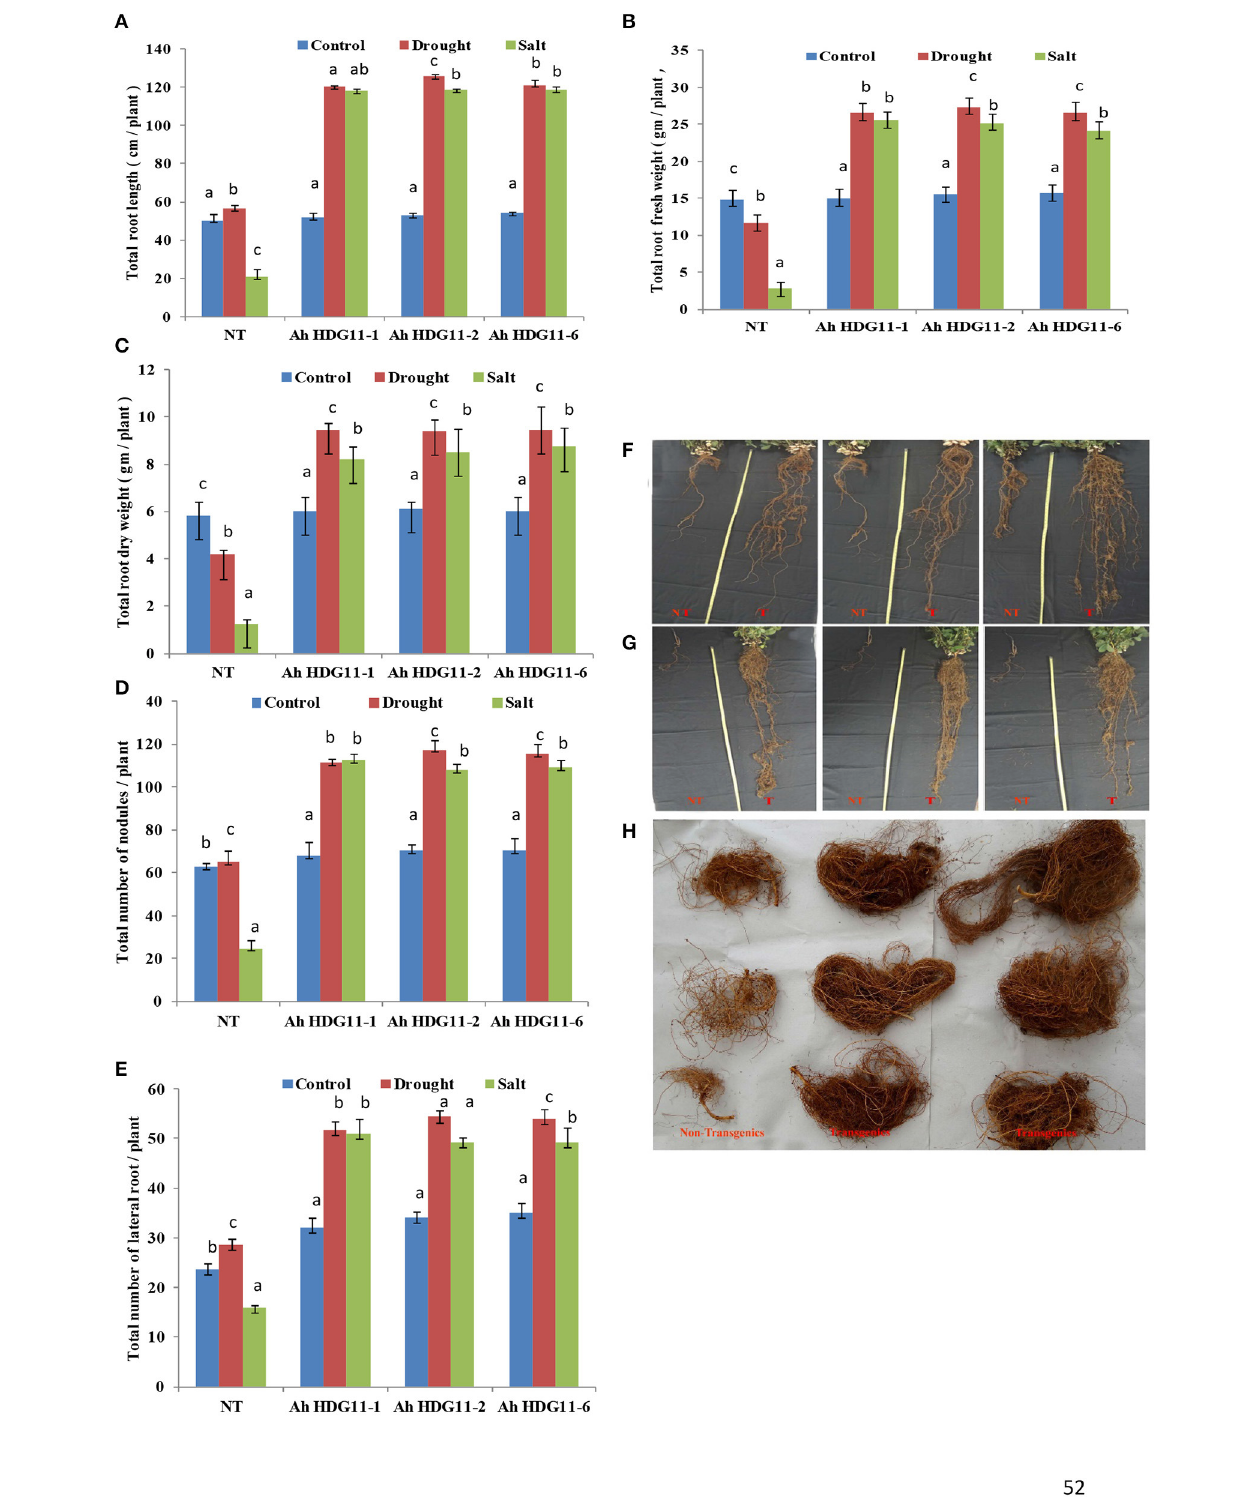
FIGURE 4 | Post-harvest root morphology, growth, and biomass analysis of three transgenic lines AhHDG11-1, AhHDG11-2 and AhHDG11-6 along with the control untransformed parent JL-24 (NT) under control (well-watered), drought and salt stress from the confined outdoor lysimetric experiment. (A) Root length (cm/plant). (B) Root fresh weight (gm/plant). (C) Root dry weight (gm/plant). (D) Root nodules. (E) Lateral roots. (F) Phenotype of roots under drought stress. (G) Phenotype of roots under salt stress. (H) Root mass of Non-transgenic (NT) and transgenic plants (T). Alphabets in lowercase indicates the statistical significance in differences between WT and transgenics at p <